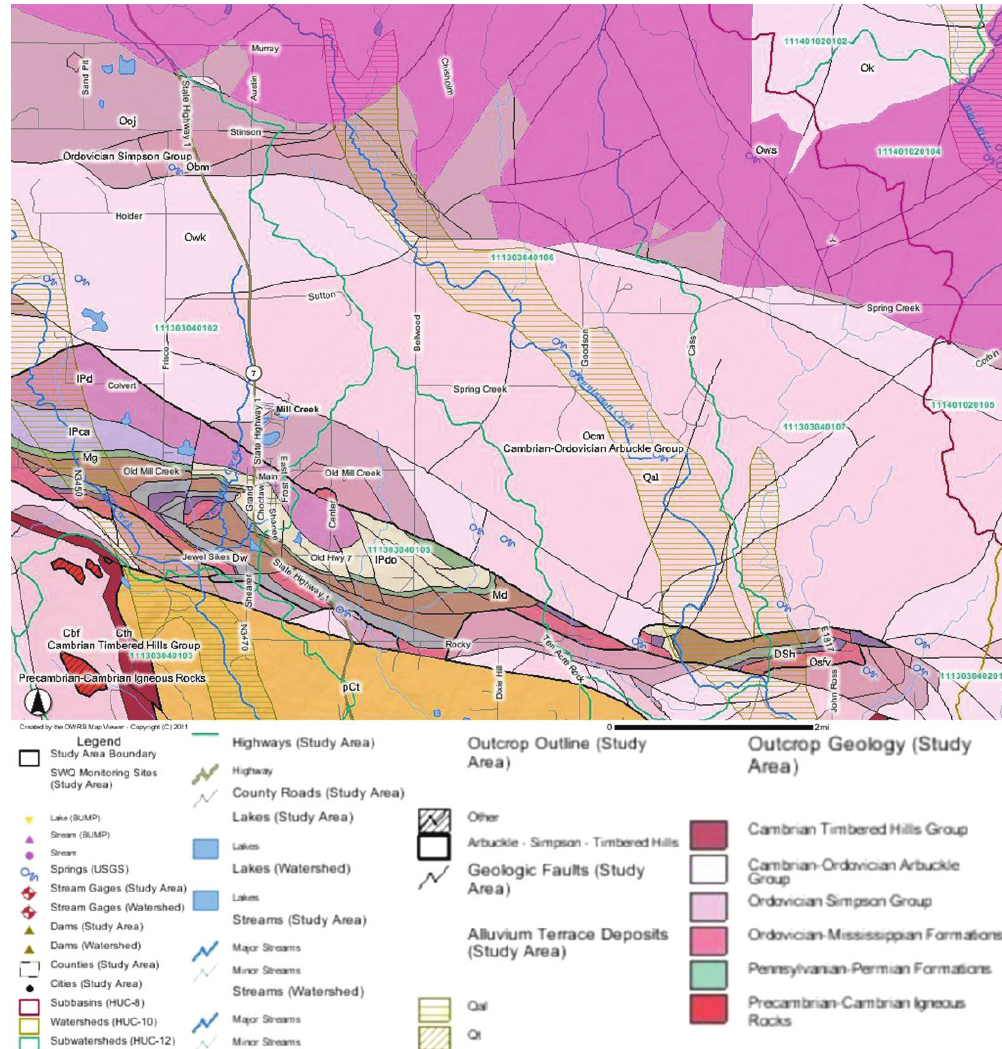
Figure 3: Hydrogeology map near Mill Creek Block of Arbuckle-Simpson